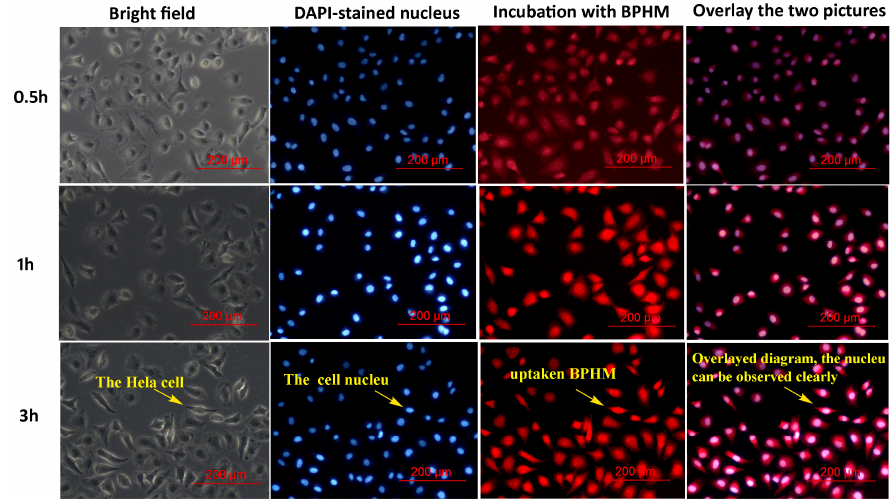
Figure 4. Fluorescence inverted microscopic images of cellular uptake test: HeLa cells were incubated with BPHM (1 mL, 50 μ g/mL) at 37 °C for 30 min, 1 h, and 3 h, respectively. The nucleus was stained with DAPI ( blue ), the red fluorescence was due to BPHM. The corresponding cells states were observed in bright field.